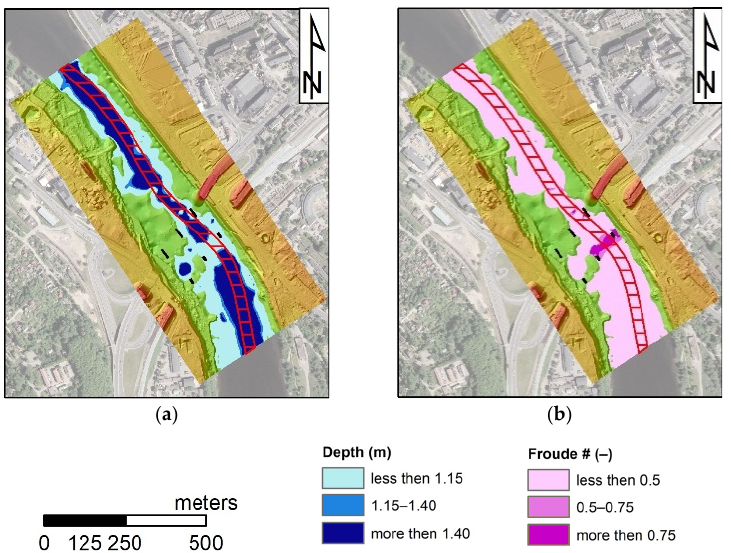
Figure 9. Example of results obtained for the roughness of the bottom equal to 0.025 s m − 1/3 and flow Q 95% . Maps of the entire model with depth and Froude #: ( a ) map of depth classes, ( b ) distribution of Froude